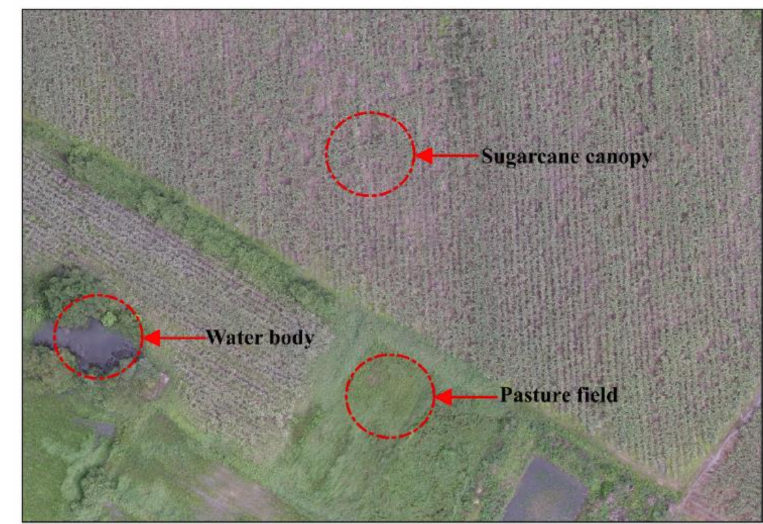
Figure 18. Example of sugarcane canopy, water body, and pasture field displayed in a UAV image observed on 16 May 2018. The UAV image shows sugarcane phenology in grand growth stages.